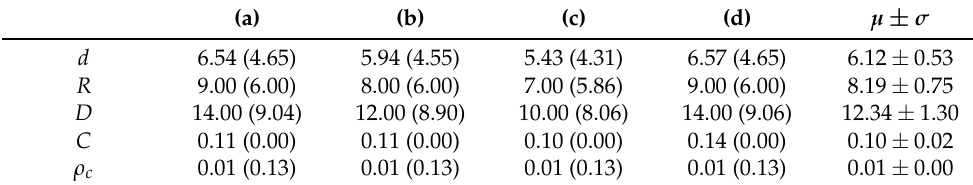
Table 4. Topological parameters of the kinetic networks of SD ensembles illustrated in Figure 6: average path distance d , radius R , diameter D , transitivity C and ground-state connectivity density ρ c . The corresponding averages µ and standard deviations σ are obtained for 100 different realizations of disorder. Results for random graphs having the same number of nodes and edges are given in